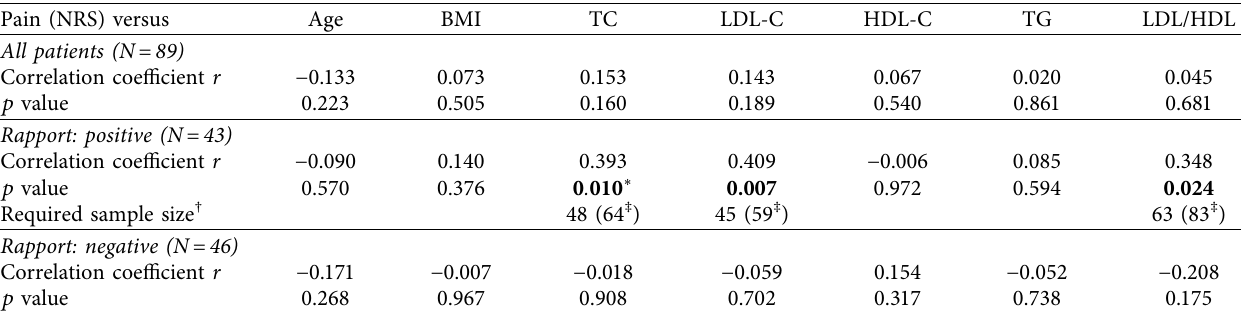
Table 2: Parametric Pearson’s correlation coefcients, p -values, and required sample sizes (only for statistically signifcant coefcients). Pain (NRS) versus